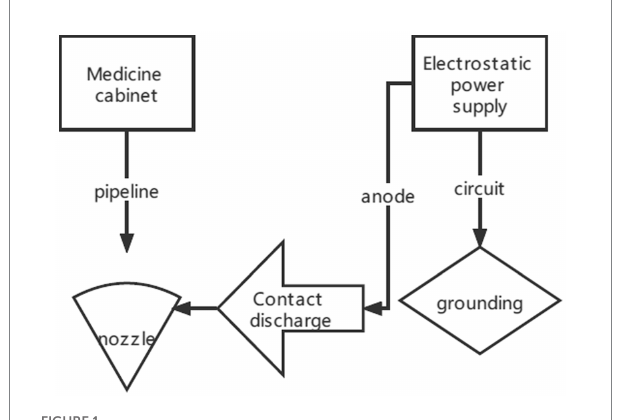
FIGURE 1 Contact charge schematic